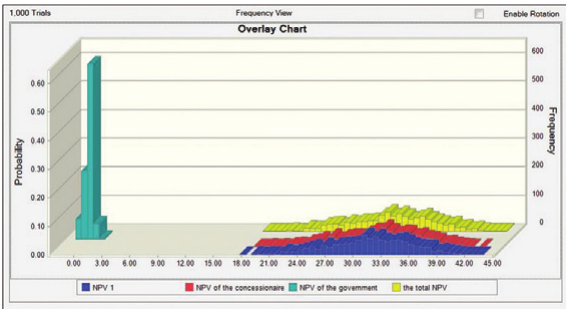
Fig. 1. The probability distribution of the NPV with and without MRG and TRC (in million EUR) Table 1. The statistical parameters of the NPV with and without MRG and TRC (in million Eur)